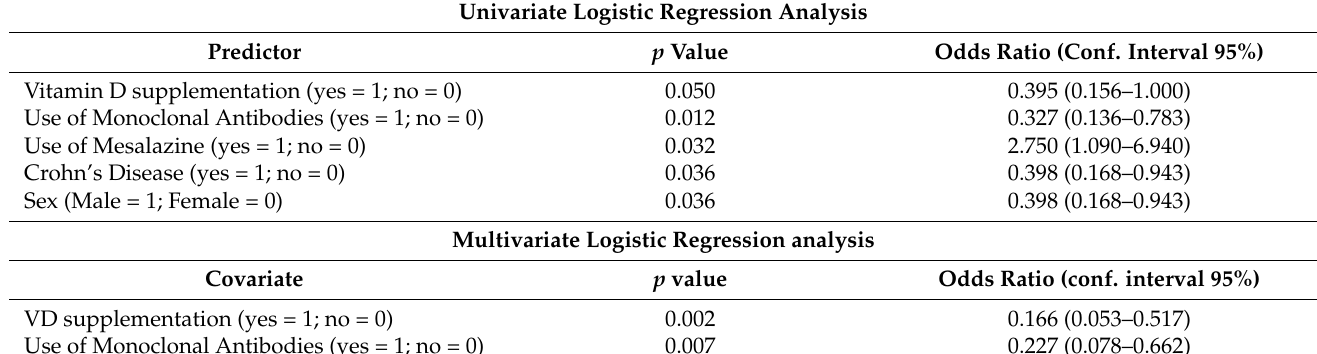
Table 2. Summary of the estimated Odds Ratios determined by univariate and multivariate logistic regression analysis for the prediction of positivity in the SARS-CoV-2 serological